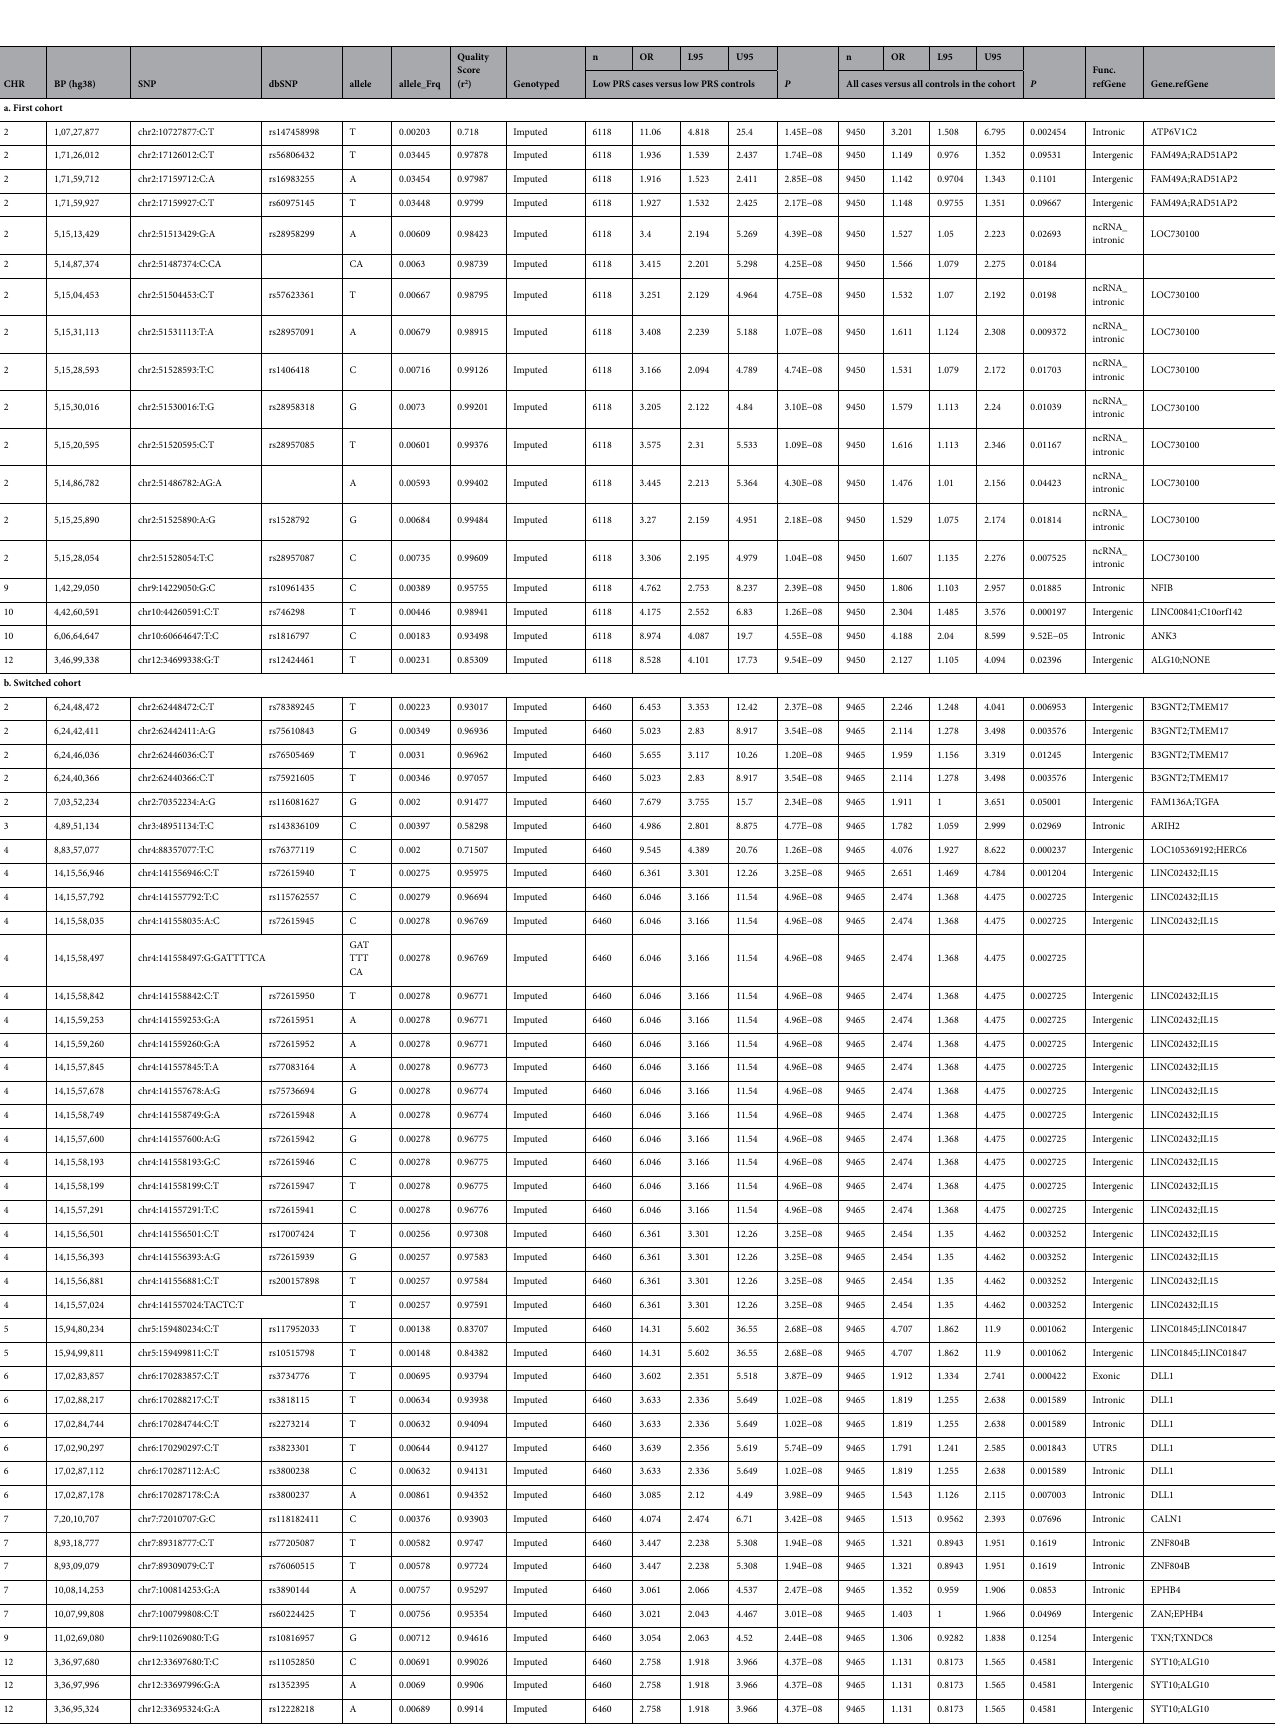
Func. refGene Gene.refGeneLow PRS cases versus low PRS controls All cases versus all controls in the cohort